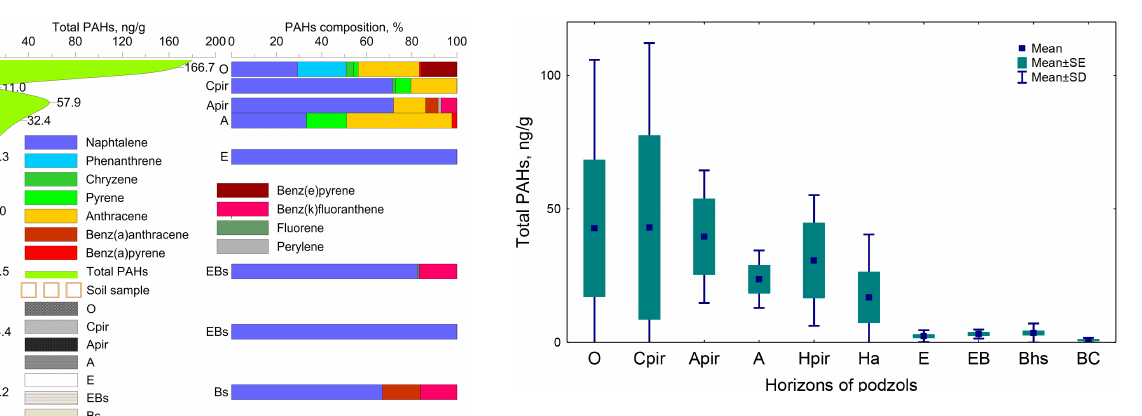
Figure 11. The categorized box and whisker plot for total PAHs in different horizons of podzols (pits 2, 3, 4, 5, and 6). The number of sample replicates: O-6; Cpir-4 Apir-3; A-3; Hpir-3; Ha-6; E-9; EB-5; Bhs-15; BC-4. Horizons Bh, Bs, and Bhs were combined for this analysis into